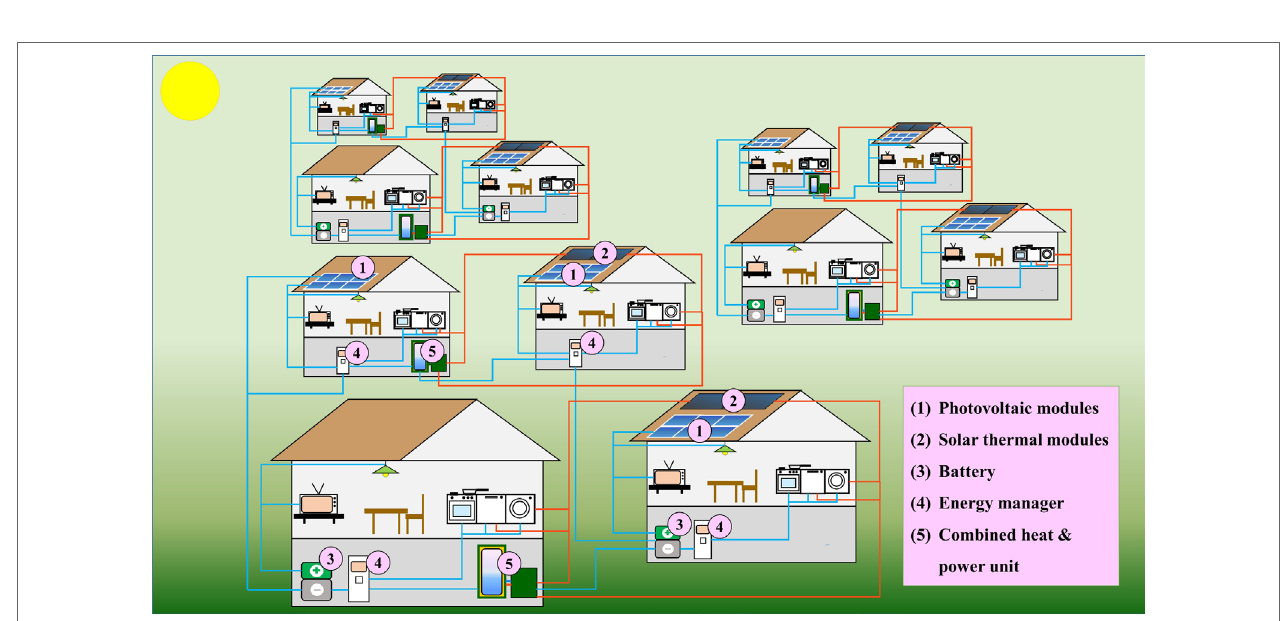
FigUre 4 | Small Town Scenario: energy autarky on the small town